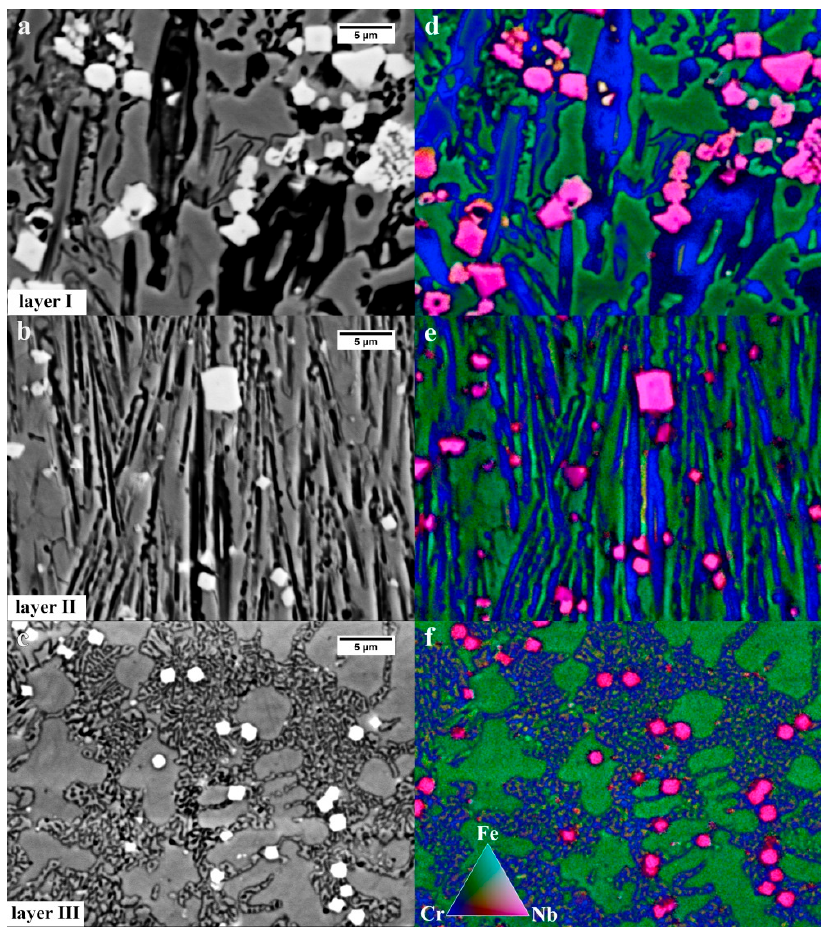
Figure 9. ( a ) Chemical elements distribution. ( a – c ) Microstructures obtained with the material contrast- BSE detector. ( d – f ) Sum of EDX mappings for Fe, Cr, and Nb. Scanning electron microscopy.